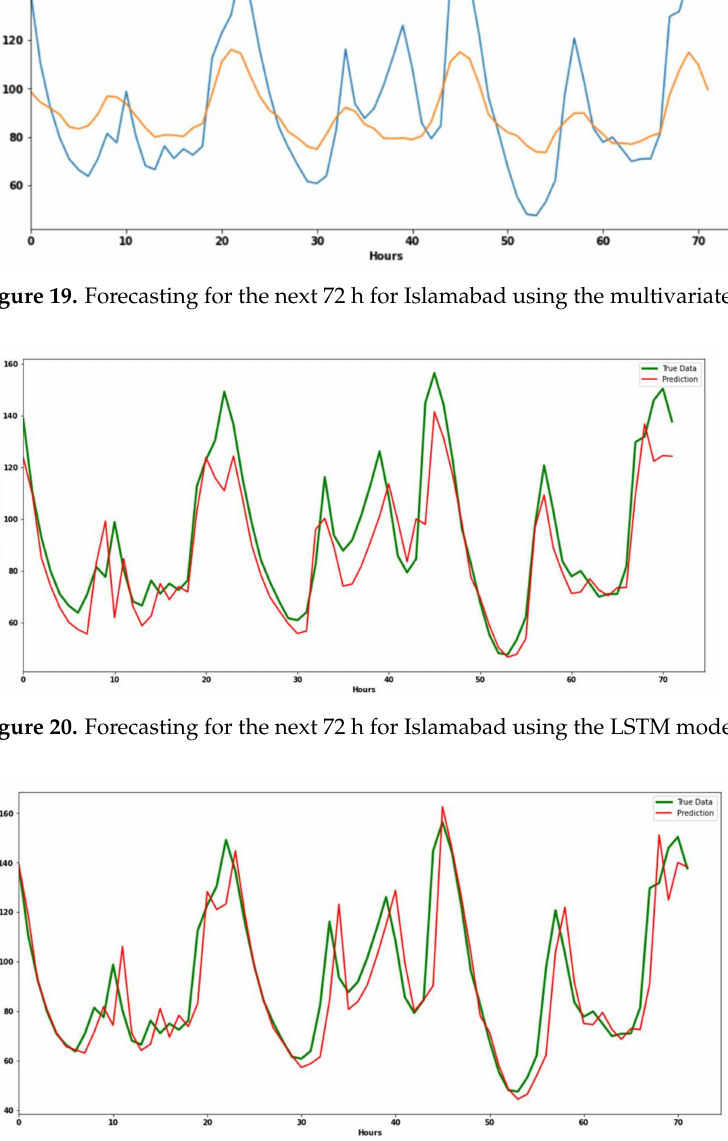
Figure 21. Forecasting for the next 72 h for Islamabad using the LSTM encoder–decoder